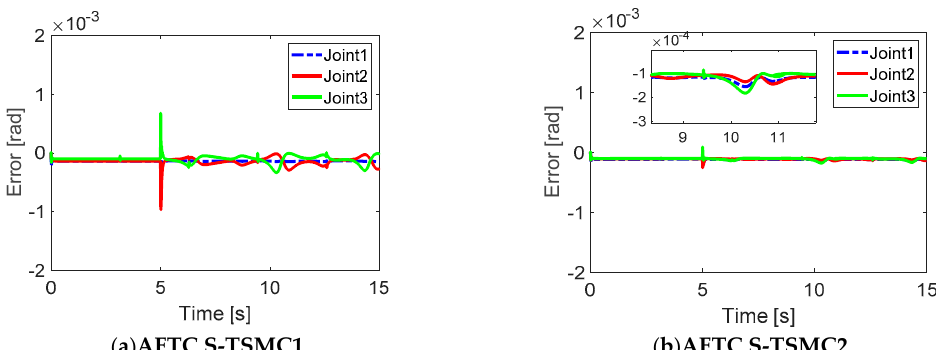
Figure 5. Tracking error at each joint with a single fault at joint 2.